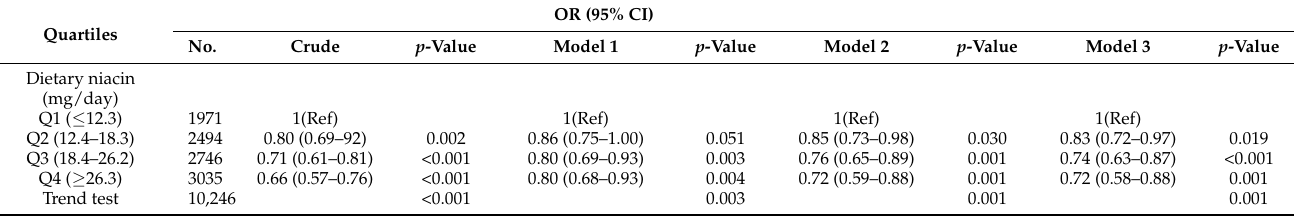
Table 3. Association between dietary niacin intake and